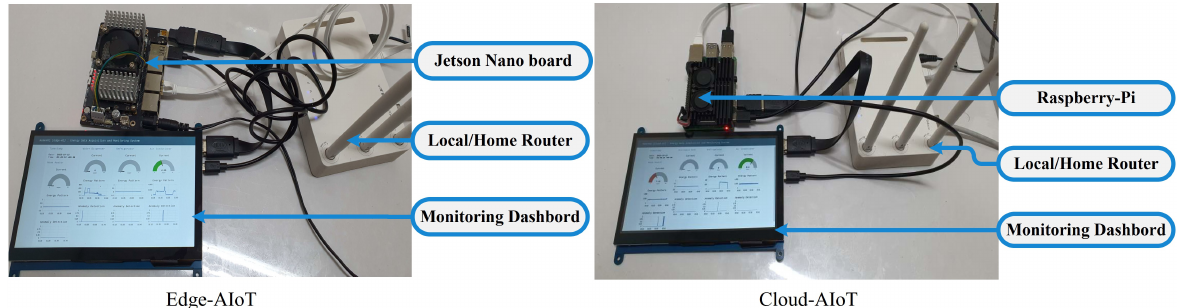
Figure 9. Edge and cloud AIoT setup in the edge IIoT system.